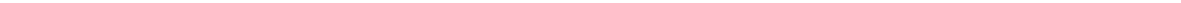
Fig. 4 Effector caspase activity inhibits ICM independently of apoptosis. a Induction of ICM in WDs from a series of irradiated (18 Gy) transgenic and mutant fl ies with gradual decrease in their apoptotic potential. Each panel ( I – V ) contains the genotype, a representative WD with migrating cells at 48 hpi, the total number of drice and dcp-1 gene copies, and three graph bars, indicating the apoptotic potential (TUNEL levels relative to WT, red), effector caspase activity levels (PARP [within the CPV] cleavage levels relative to WT, blue), and ICM levels (migrating cell levels relative to the dcp-1 − / − ; drice − / − double mutant, green). P values were calculated as follows: for TUNEL, P < 0.001 between all the genotypes, one-way ANOVA followed by Tukey multiple comparisons post hoc test; for cPARP, P < 0.001 between all the genotypes except P < 0.05 between WT and drice − / − and NS between WT and drice:dcp-1 ; drice − / − , one-way ANOVA followed by Tukey multiple comparisons post hoc test; for ICM levels, the signi fi cance between each of the different genotypes and the dcp-1 − / − ; drice − / − double mutant was P < 0.001, two-way ANOVA followed by Tukey multiple comparisons post hoc test. Due to the variance in the double mutant, a similar analysis was then performed after excluding the double mutant to test the signi fi cant difference among the different genotypes ( P < 0.001). Error bars indicate s.e.m. The examined WD numbers ( N ) are indicated for each graph bar. Scale bar, 50 µ m. b WD pouch areas of the indicated genotypes after ICM induction (50 Gy, 72 hpi). The lower panels show Z -axis projections corresponding to the dashed lines regions in the upper panels. Arrows indicate compact and rounded delaminating/migrating cells that lost E-cadherin expression. Scale bars, 20 µ m. c High magni fi cation fl uorescence images of three migrating cells in area proximal to the pouch. Arrow indicates a fi lopodium. Scale bar, 5 µ m. d Illustration of a cell with the small GTPases that orchestrate cell movement. e-g Pouch area inactivation of the Rho small GTPases attenuates ICM. Representative images of irradiated WDs (18 Gy, 48 hpi) of the indicated genotypes ( e ), and the corresponding quanti fi cations of ICM levels, presented either as migrating cell number averages relative to control ( f ) or as the percentage of WDs with each of fi ve different migrating cell number categories (color coded by different shades of blue; g ). Arrow indicates clustering of cells near the pouch. The examined WD numbers ( N ) are indicated for each graph bar. Error bars indicate s.e.m. *P < 0.05, **P < 0.01, ***P < 0.001, two-way ANOVA. Scale bar, 50 µ